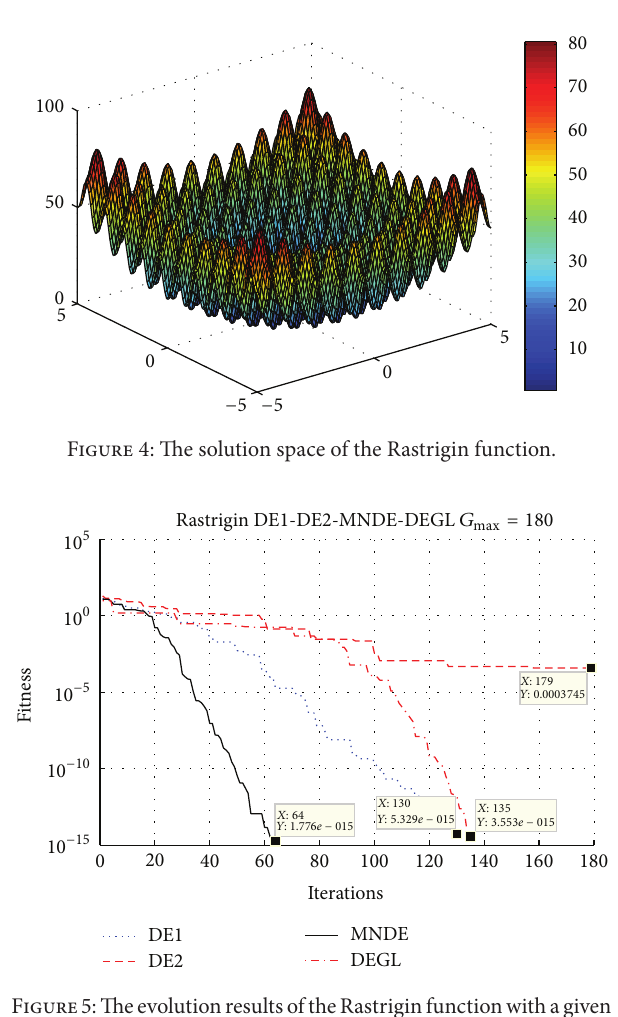
Figure5:TheevolutionresultsoftheRastriginfunctionwithagiven predefined number of iterations.